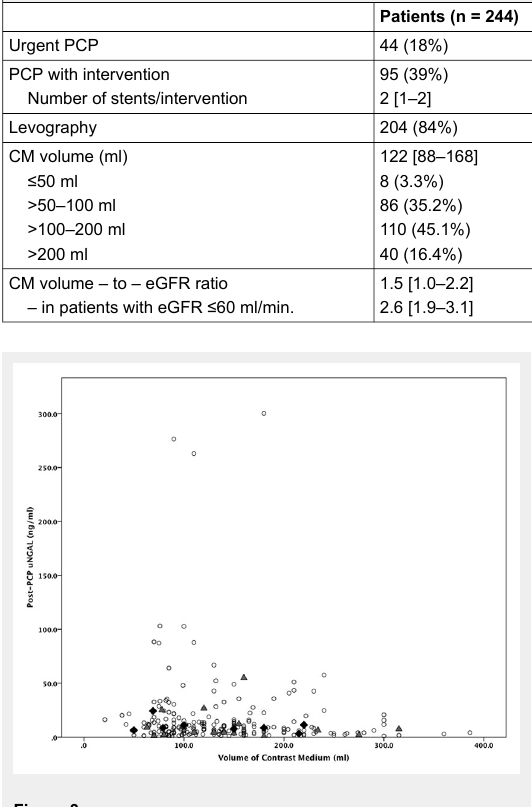
Table 2 : Procedural characteristics in patients undergoing PCP. Data are presented as median [interquartile range] or number of patients (%). CM = contrast medium; eGFR = estimated glomerular filtration rate; PCP = percutaneous coronary procedure.